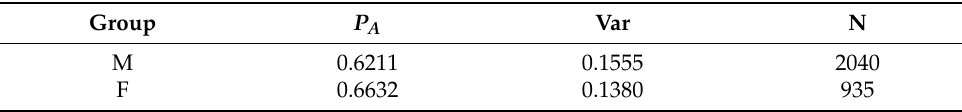
Table 4. Academic performance indicator values by